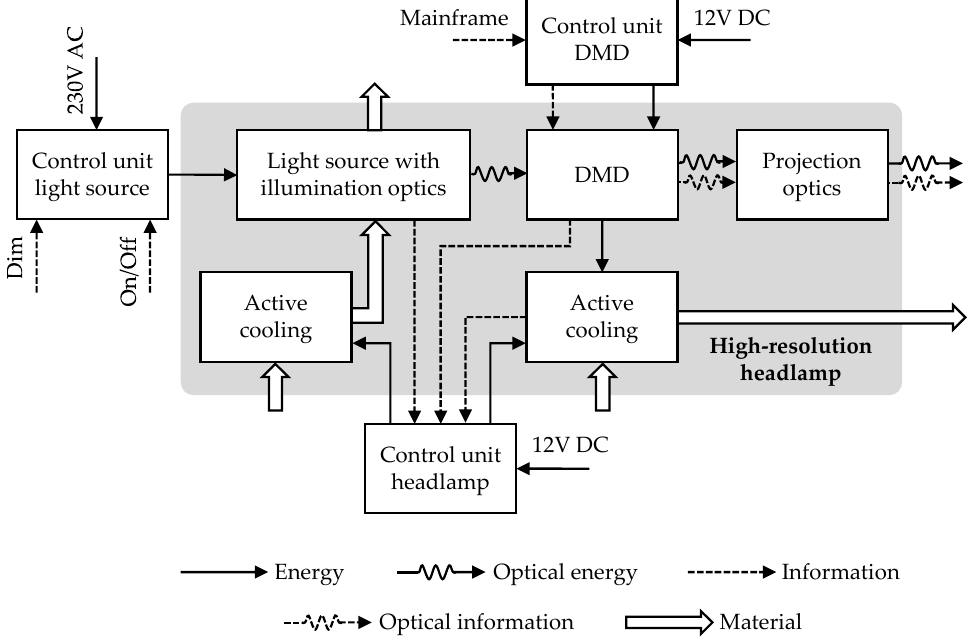
Figure 11. Cross-domain solution concept of a high-resolution lighting system according to